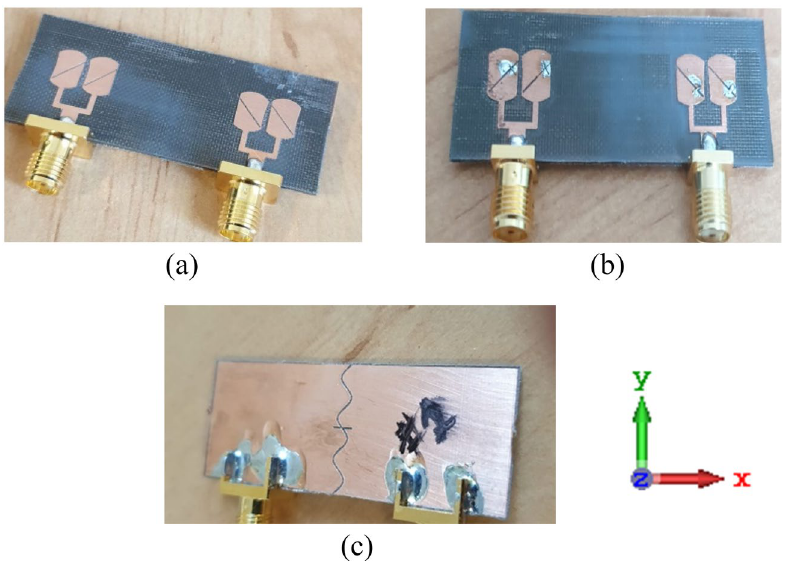
Figure 17. Fabricated antenna ( a ) front view (OFF-state), ( b ) front view (ON-state), ( c ) back